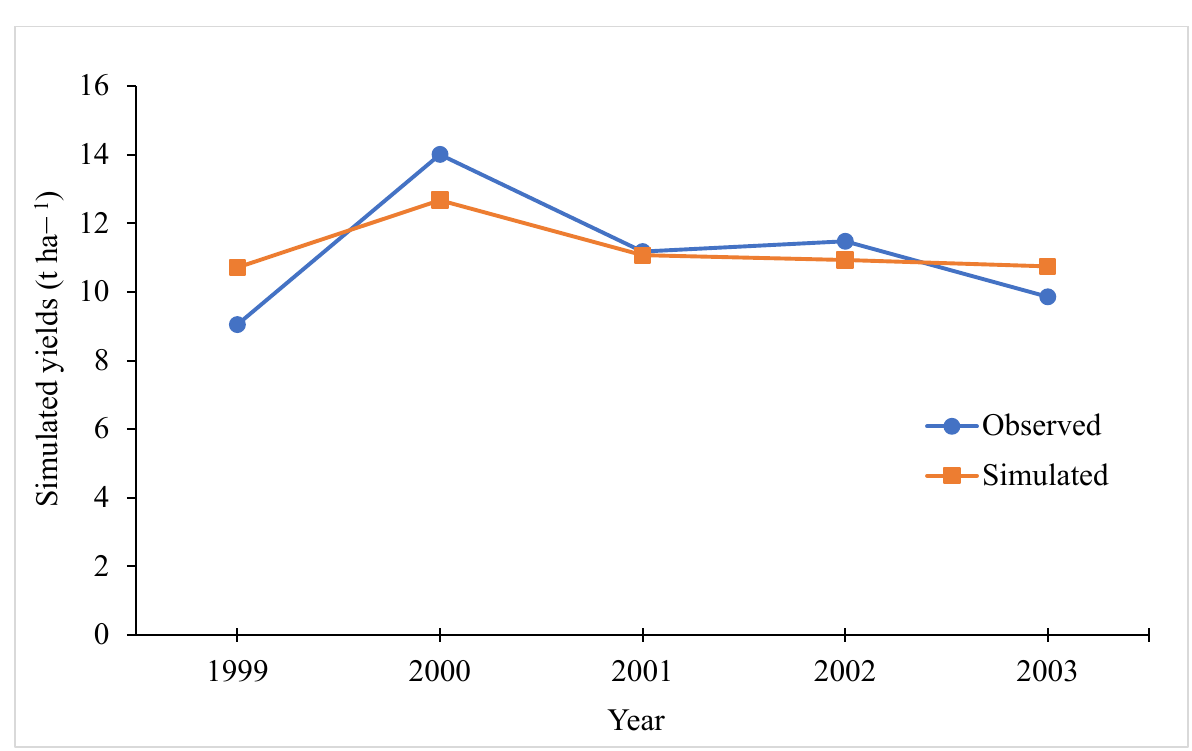
Figure A2. Showing the simulated crop yields on observed maize yields with the calibrated maize crop file (figure obtained from [32]).